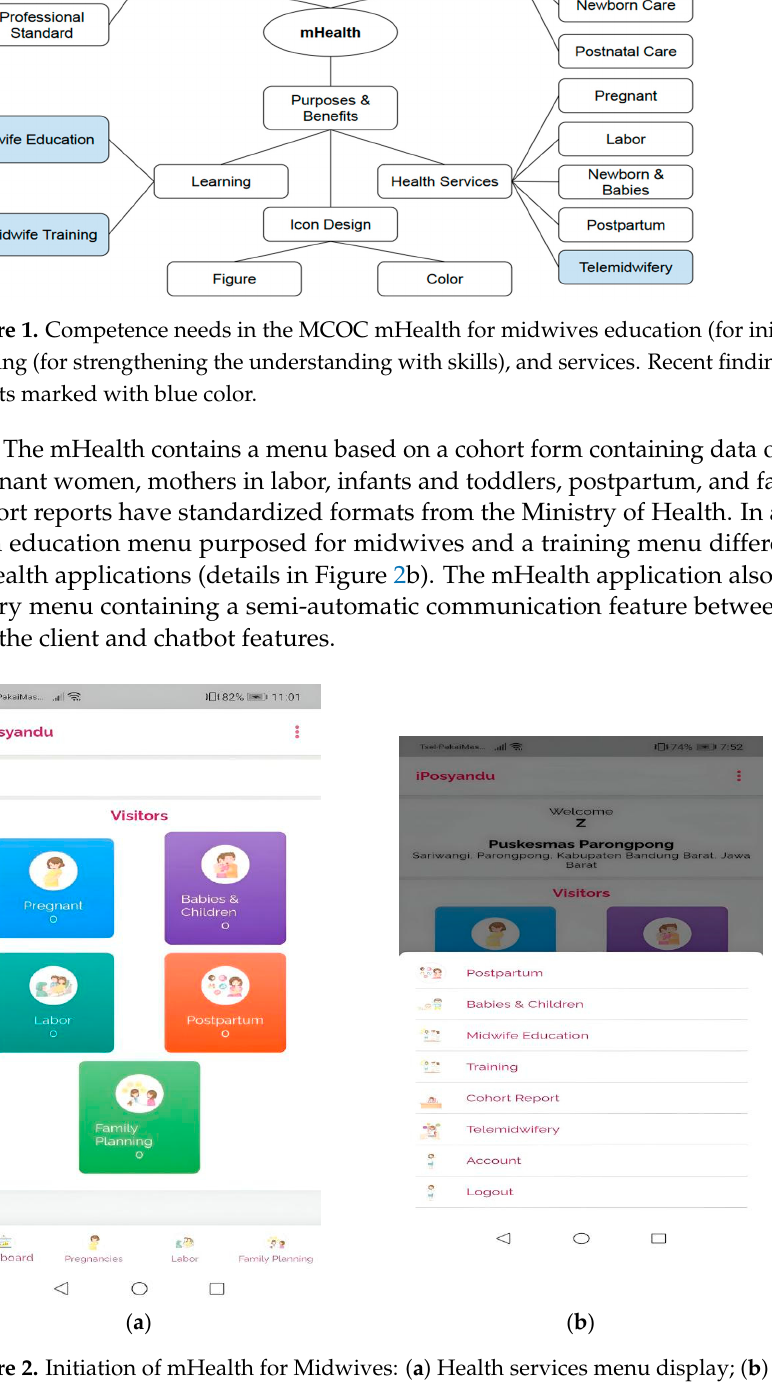
Figure 3. Data Flow Diagram (DFD) level 0 in mHealth application for a midwife.